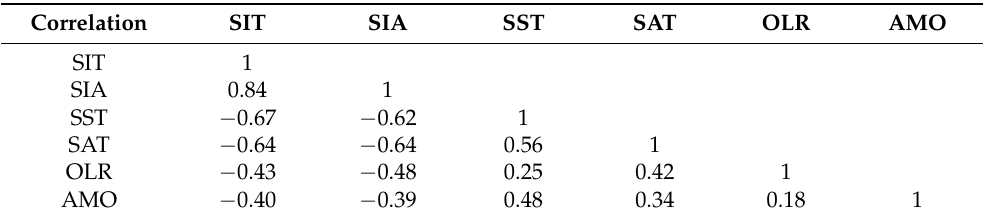
Table 6. Correlation matrix of the monthly anomalies (1979–2020) of SIT, SIA and atmospheric, oceanic parameters for the Barents–Kara Seas (the numbers are statistically significant at a confidence level of